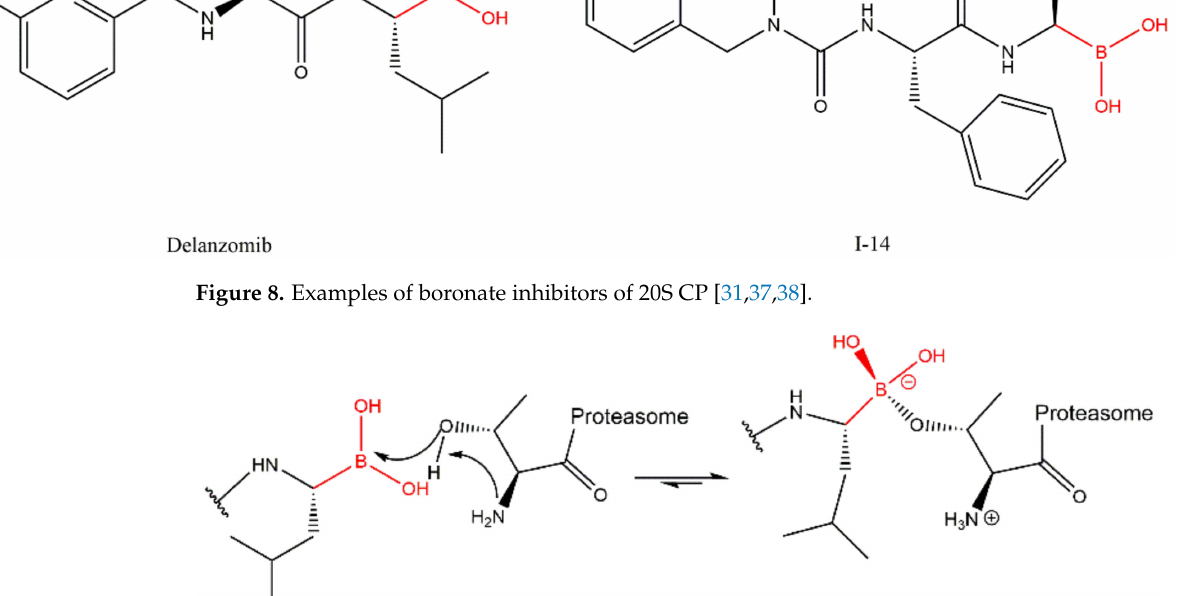
Figure 9. Mechanism of 20S CP inhibition by boronate inhibitors. The hydroxyl group from Thr1 reacts with the boronate from the inhibitor, with the formation of a borate, a tetrahedral boron anion